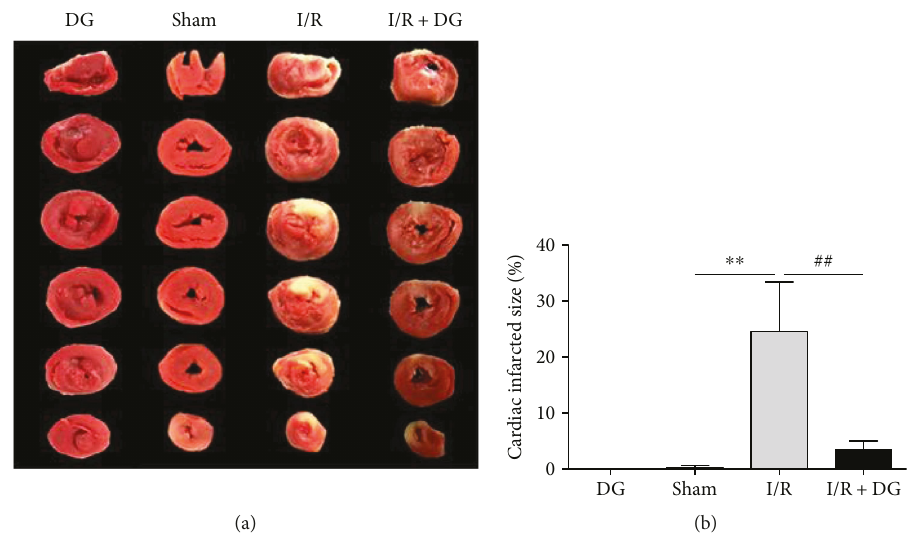
Figure 1: Dunye Guanxinning reduced cardiac infarct size. (a) 2,3,5-Triphenyltetrazolium chloride (TTC) staining of heart slices; (b) sizes of myocardial infarcts presented in Figure 2(a) ( n = 6 or 7 each). Data are expressed as mean ± SD. ∗∗ P < 0 01 versus sham operation group; ## P < 0 01 versus I/R